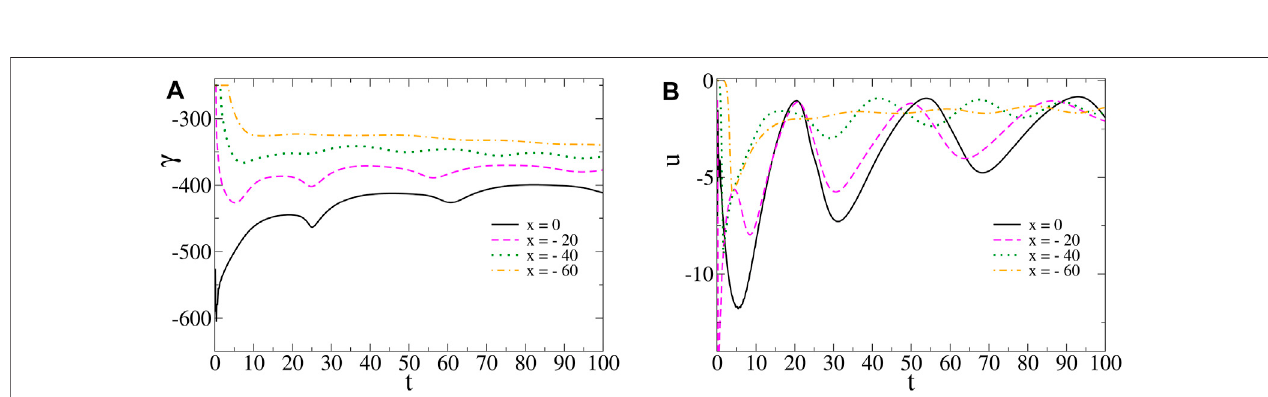
FIGURE4|(A,B) Productconcentration c S and (C) horizontalcomponentofthe fl uidvelocity fi eld u S ,atthesurface,atdifferenttimesandforthesameparameters values as in Figure 2 . We note wave-like tails in the pro fi les of c S and oscillations in the pro fi les of u S .